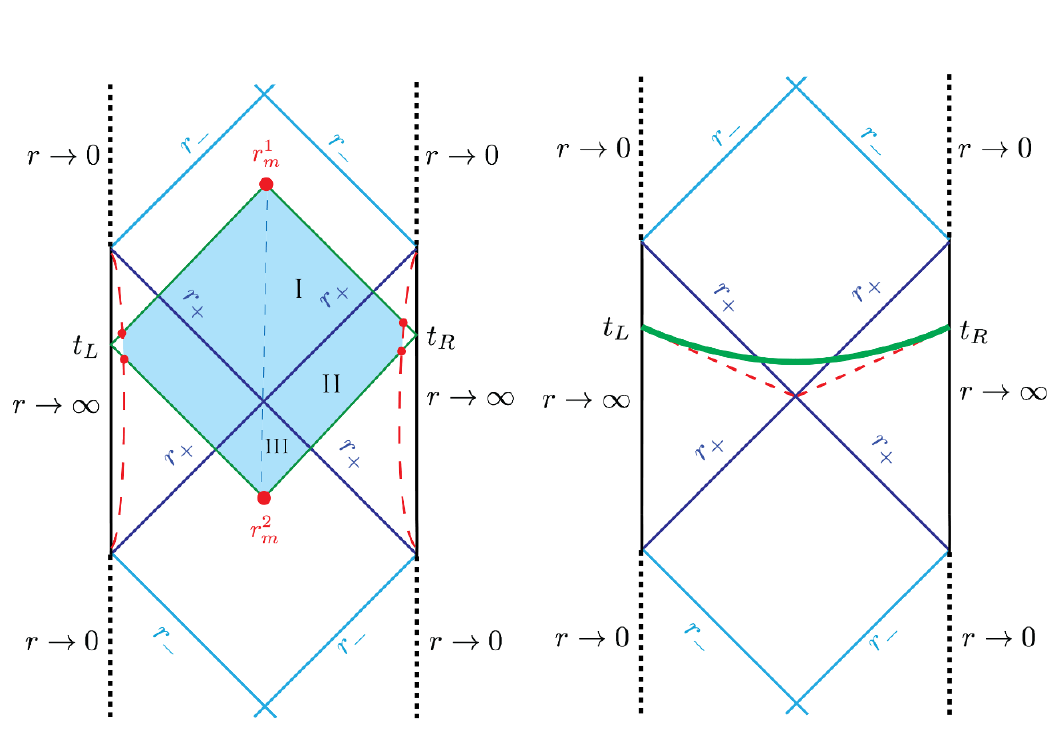
Figure 8 . Penrose diagrams for a charged black hole. On the left (cid:12)gure we breakdown the action calculation for the Wheeler-DeWitt patch. The future (past) corner approaches the inner (outer) horizon in the late time limit. On the right, we identify the maximal volume that is evaluated in the CV proposal. As in section 2 we have for the case of a general boundary size t = L